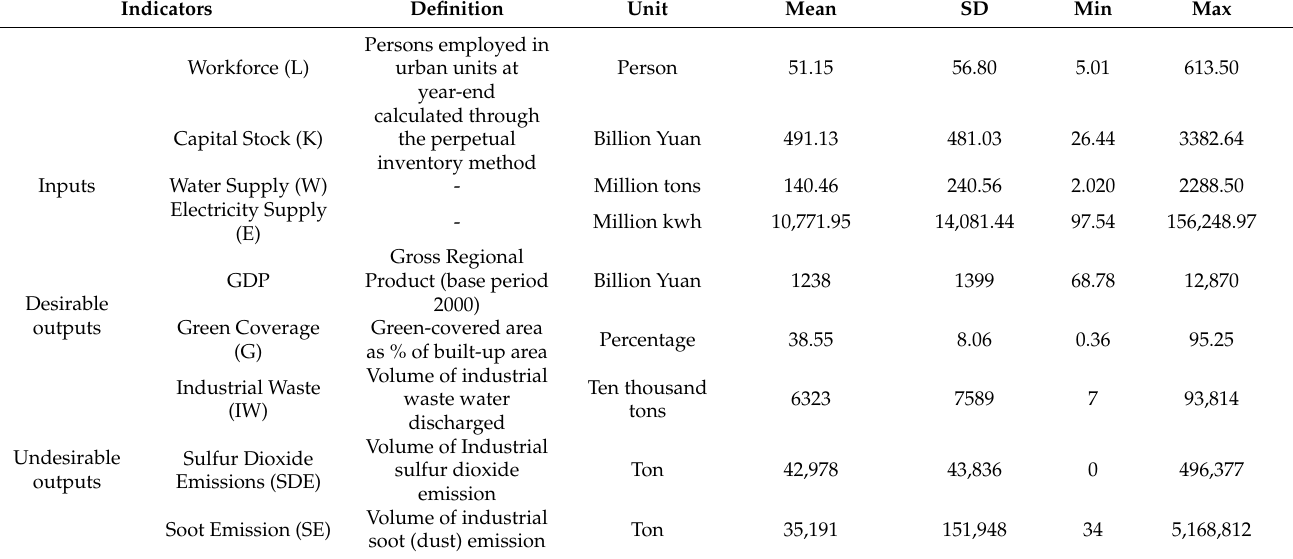
Table 2. The definitions and descriptive statistics of the input and output indicators for GTFP’s